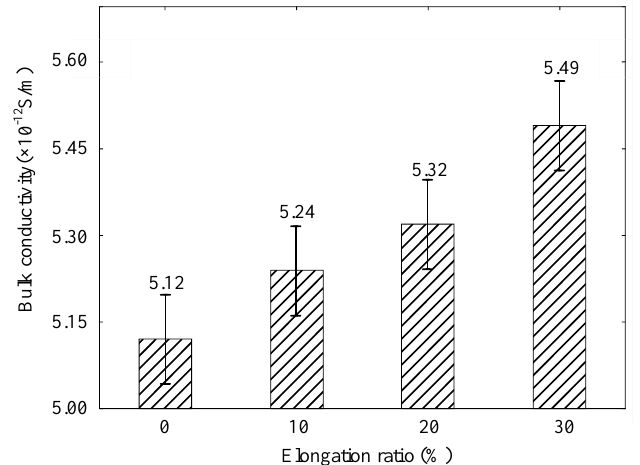
Figure 7. Electrical conductivity of polyethylene at different elongation ratios.